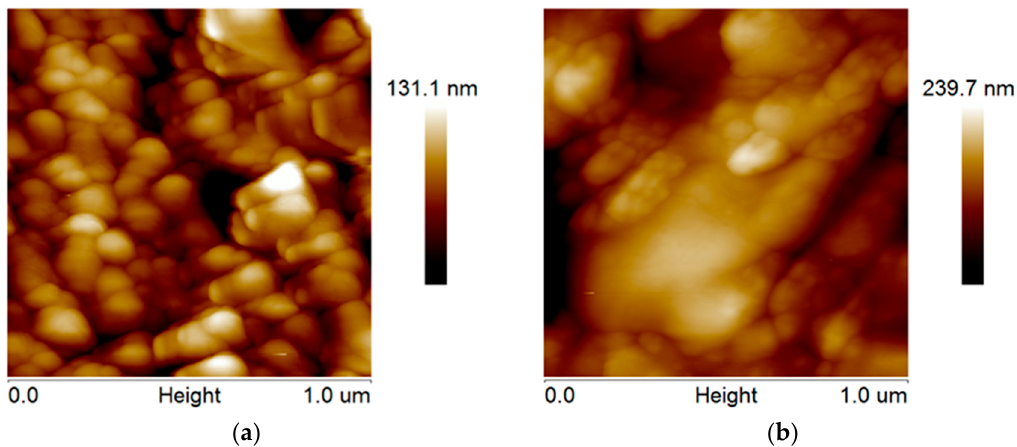
Figure 9. ( a ) AFM image for SPC TTF E control electrode; and ( b ) AFM image for AuNPs/SPC TTF E prepared by plating at 0.18 V for 15 s.